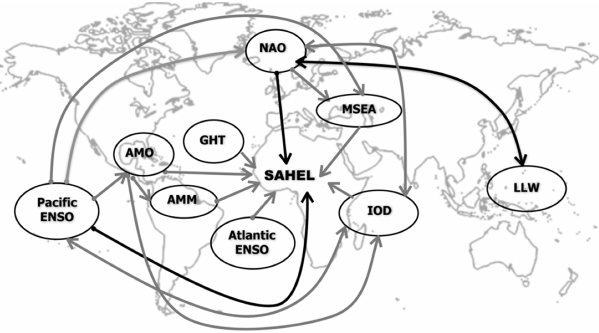
Figure 1. Complex relationships between climate indices and Sahe- lian rainfall, with some direct and indirect relationships well defined in the literature (light arrows) and others not fully understood (dark